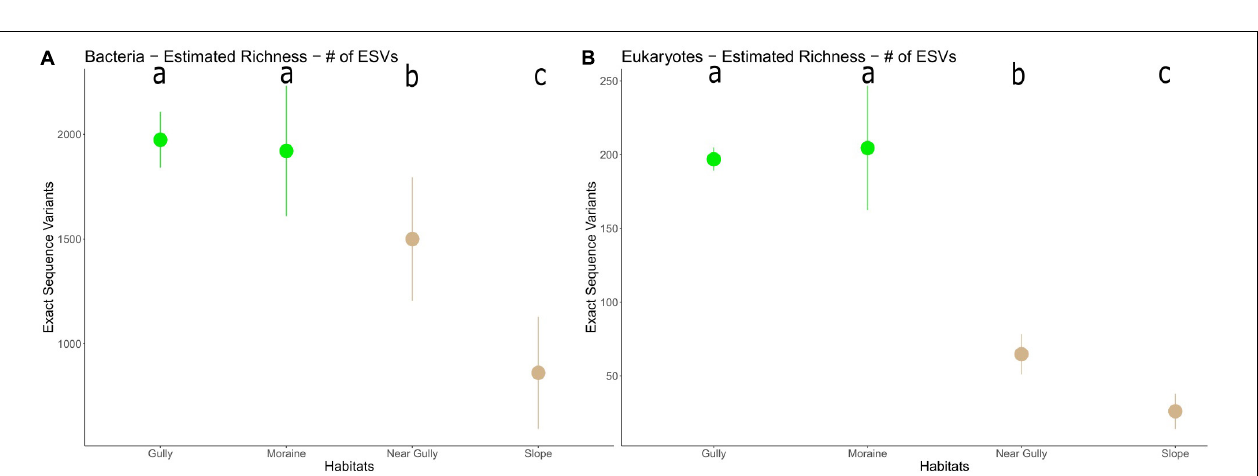
FIGURE 5 | Microbial ESV richness in each habitat (A) 16S and (B) 18S. The dots represent the mean richness in each habitat with error bars indicating 95% CI. Lower case letters indicate significant differences among habitats ( p < 0.003).